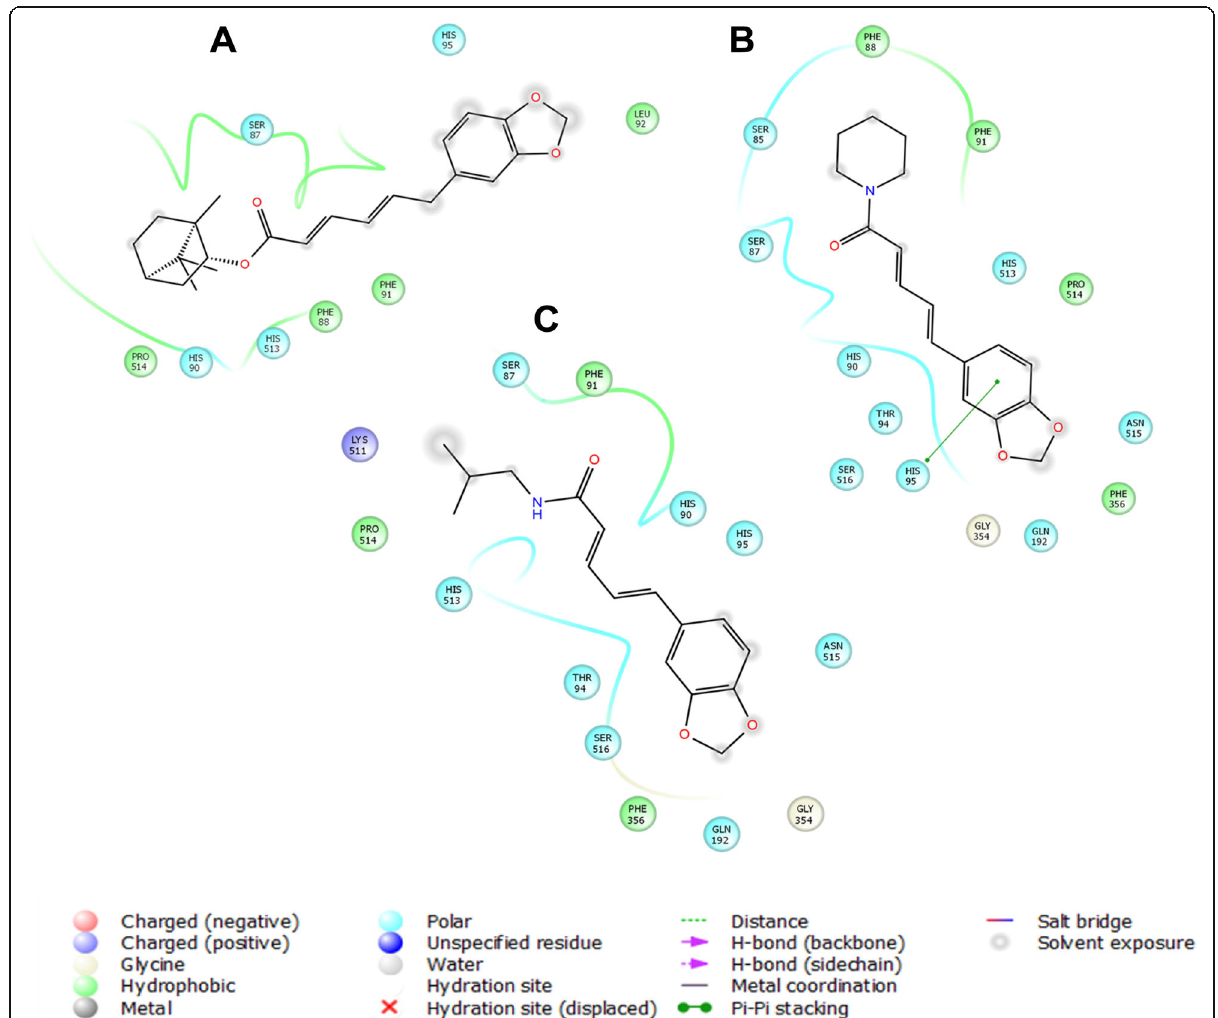
Fig. 1 Docking result of a (bornyl piperate), b (piperine) and c (piperlonguminine) with COX-1 (PDB: